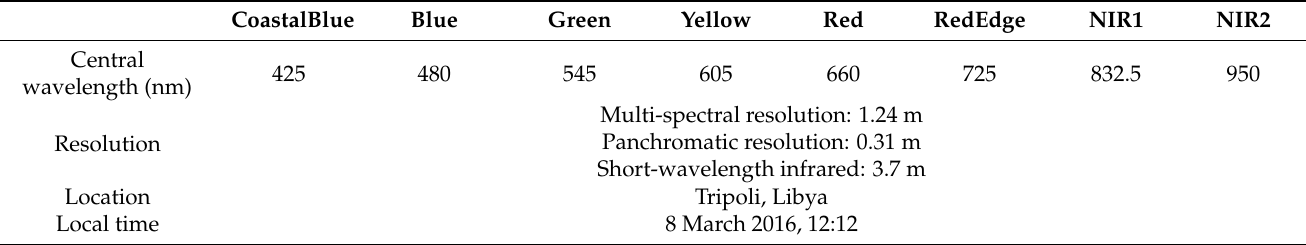
Table 1. Details of WorldView-3